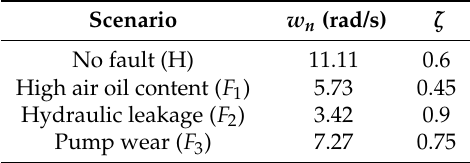
Table 1. System parameters for a hydraulic pitch actuator under common faulty scenarios